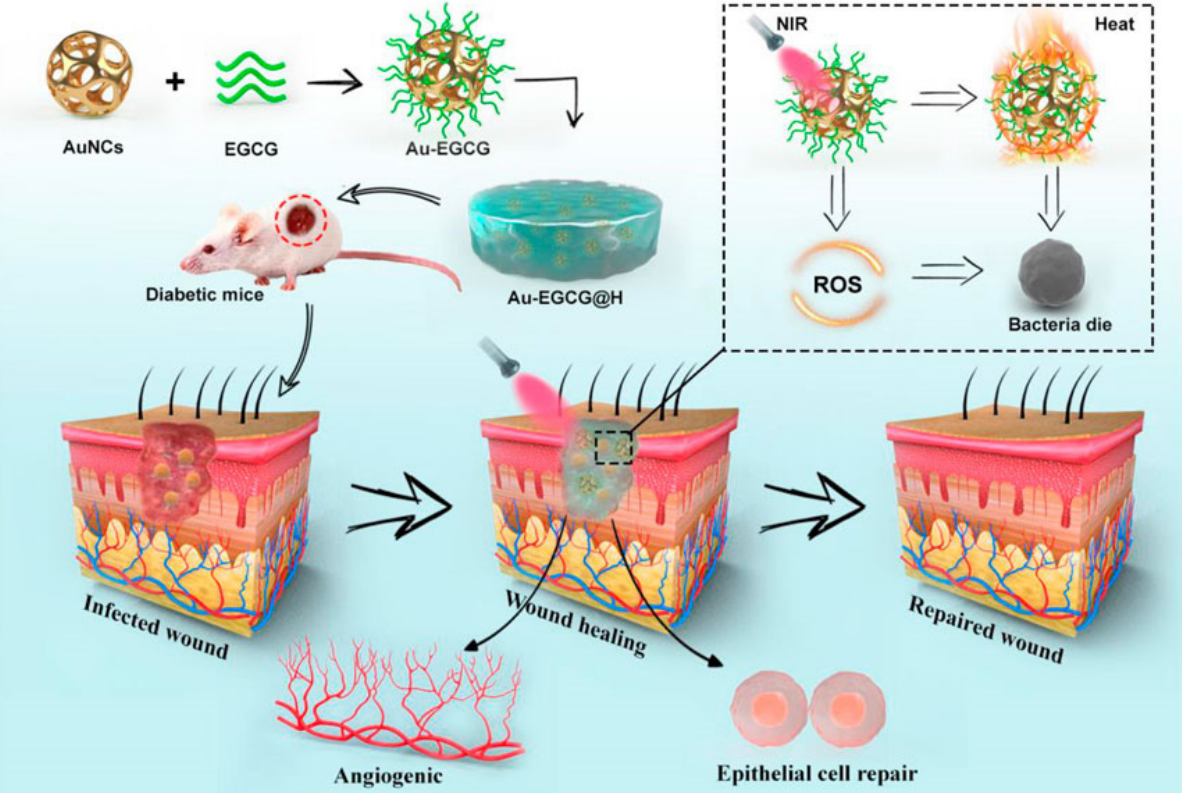
Figure 3. The schematic diagram of the synthesis of Au-EGCG@H nanocomposites and the process of sterilization under NIR irradiation. Reproduced with permission [39].